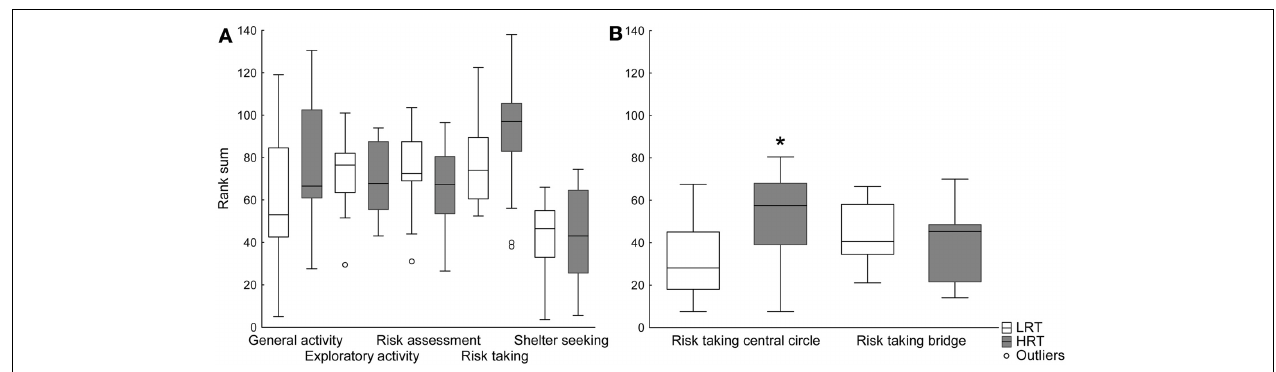
frequency and duration/frequency in all corridors and frequency in center; exploratory activity, duration in all corridors, center and hurdle, rearing and photocell counts; risk assessment, duration/frequency on slope and bridge entrance and stretch attend postures to center; risk taking, frequency, duration and duration/frequency on the bridge and in the central circle; shelter seeking, frequency, duration and duration/frequency in the dark corner